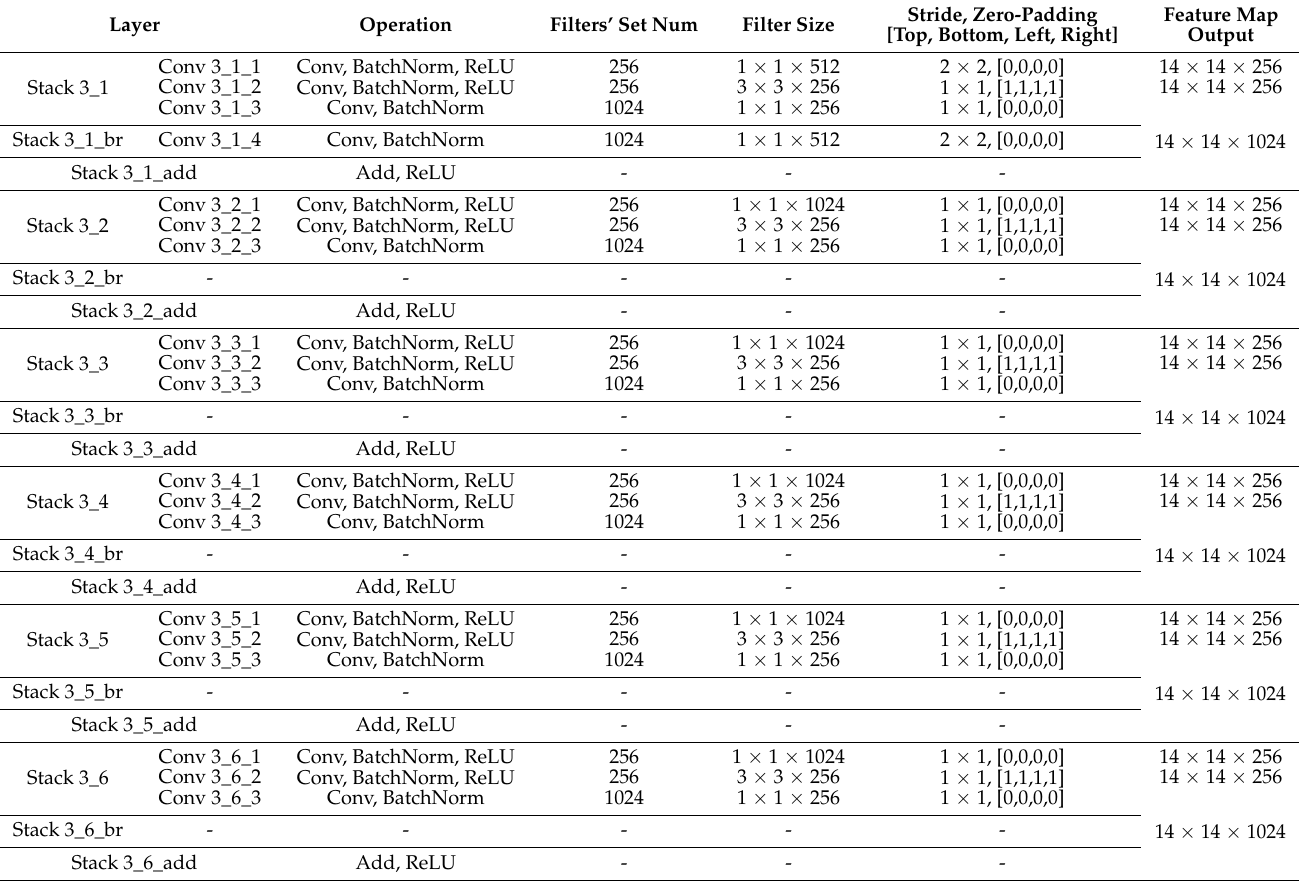
Table 3. CNN feedforward calculation in stack 3.